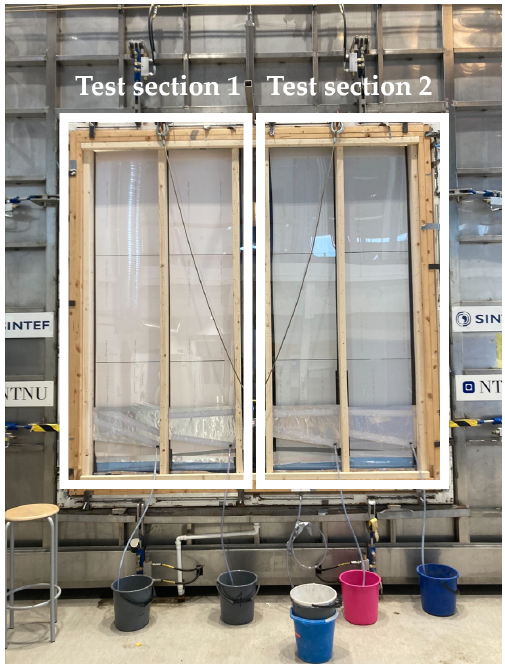
Figure 4. The test rig seen from the interior side. The water-collecting system consists of buckets and tubes. The left side of the rig is test section 1, and the right side is test section